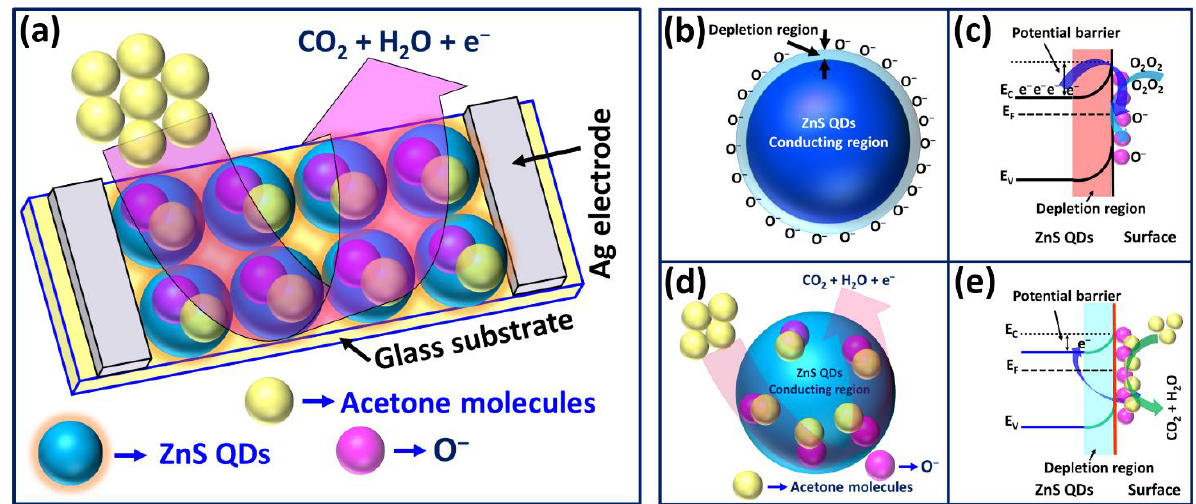
Figure 7. ( a ) Schematic view of ZnS QDs sensor, oxygen adsorption, and acetone reaction; ( b , c ) concept of interactions of oxygen molecules and formation of the depletion region on ZnS QDs sensor surface; ( d , e ) schematic view of oxygen adsorption, ionic site formation, and chemisorption of acetone molecules on the surface of ZnS QDs.